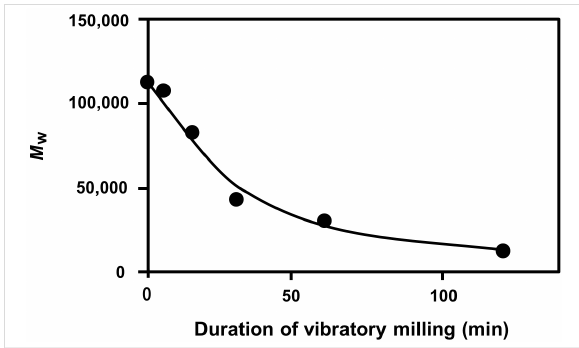
Figure 9: Changes in Dx weight-average molecular weight ( M w ) during vibratory milling.